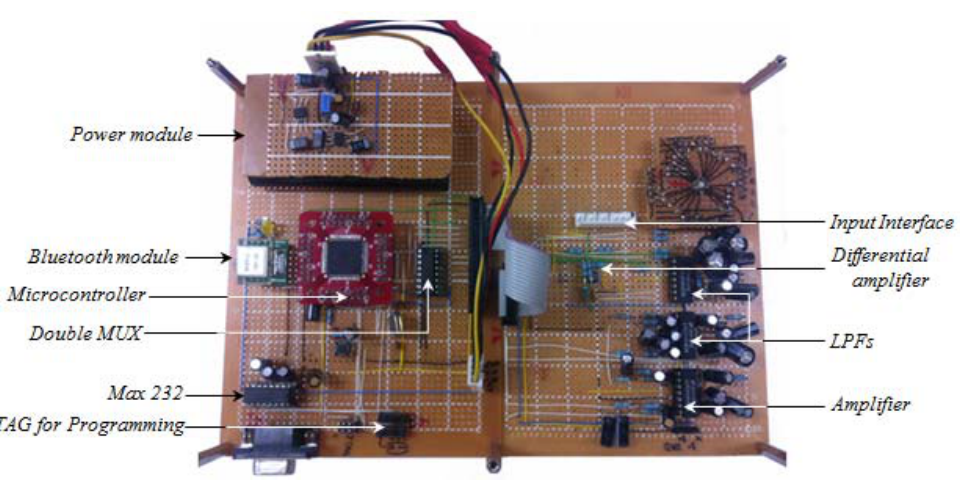
Figure 7. View of the prototype